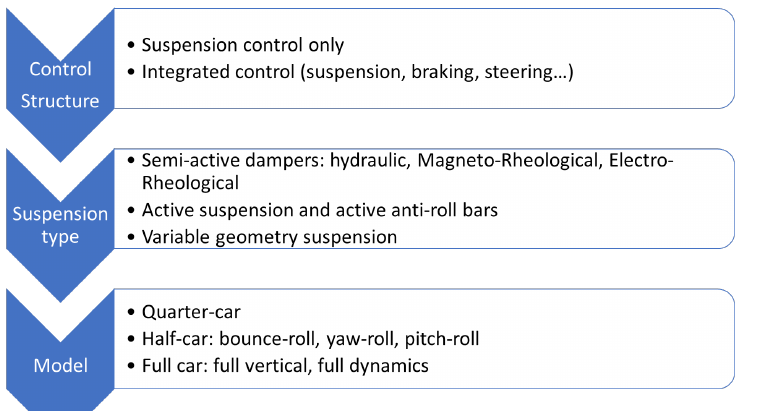
Figure 7. Overview on suspension